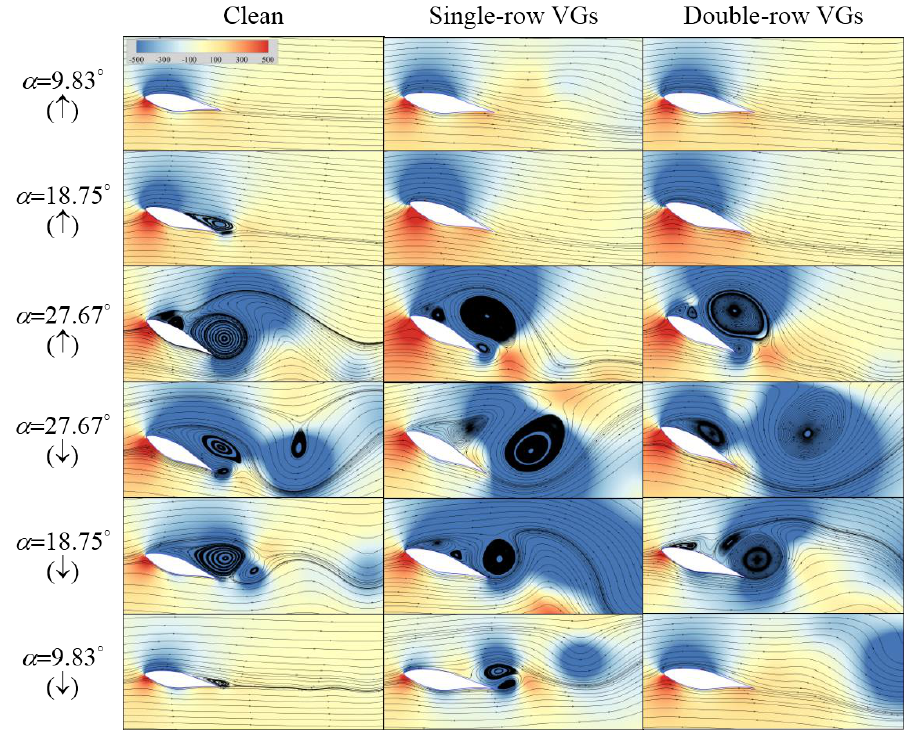
Table 3. Dynamic-stall parameters of the airfoil with and without VGs. Case Name